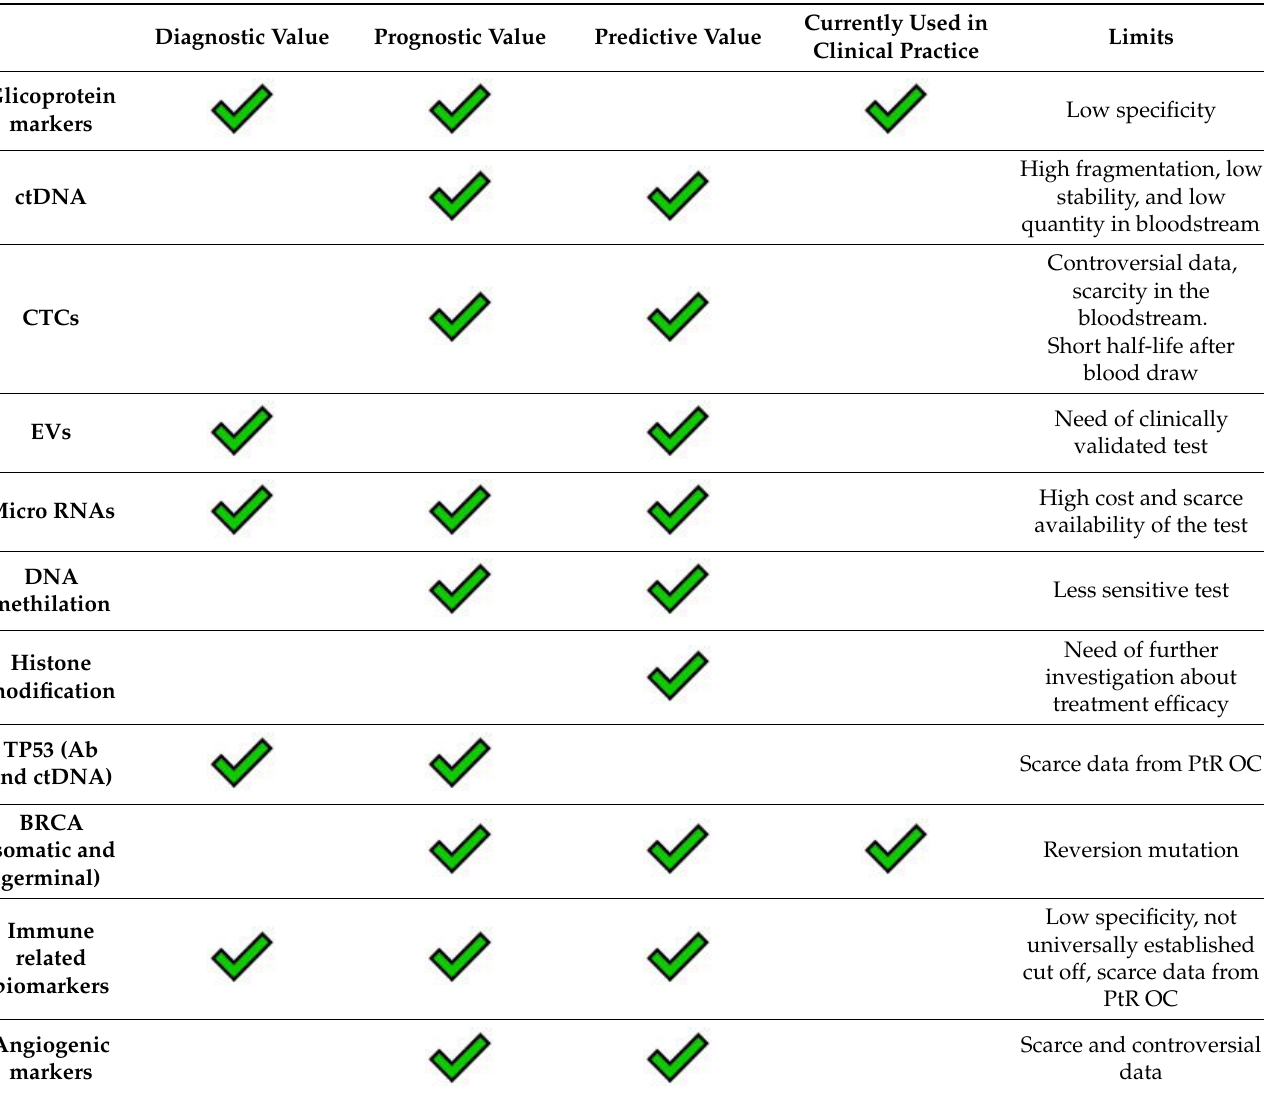
Table 7. Circulating biomarkers in PtR OC, their potential role and